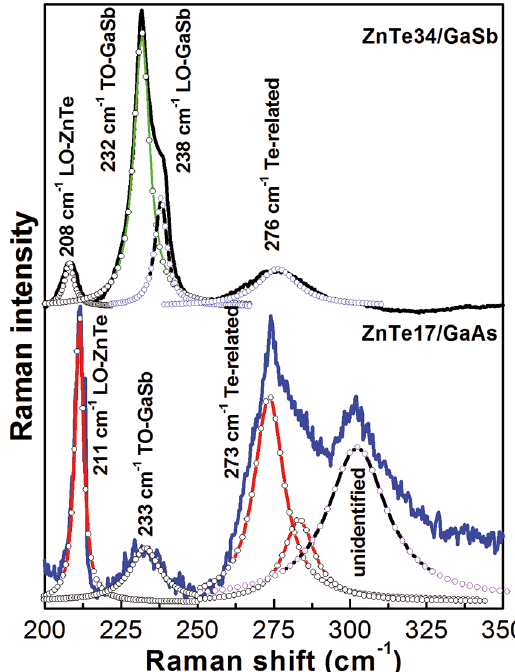
Figure 7: Raman spectra of ZnTe samples grown with different thicknesses and